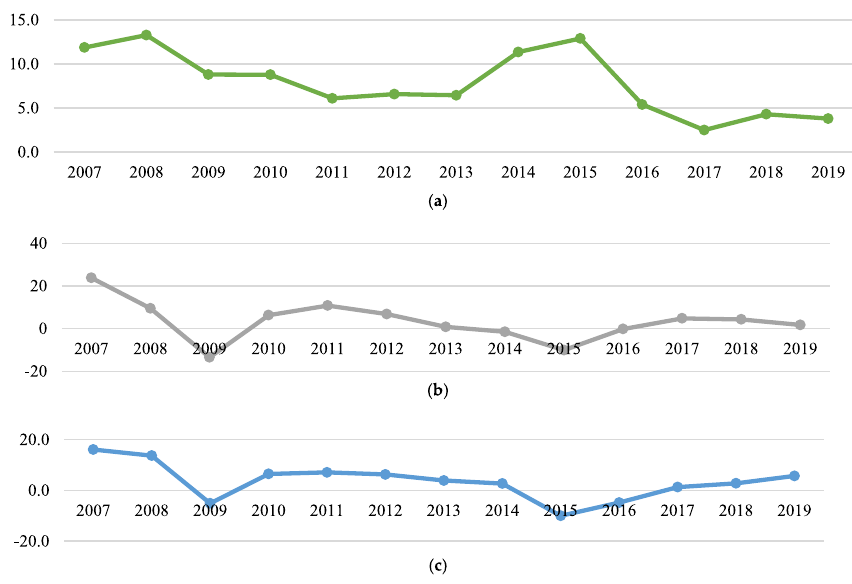
Fig. 2 a Inflation rate (CPI), %. b Growth rate of investment in fixed assets, %, c Growth rate of retail trade turnover, %. Sources : Goskomstat (2022), Bank of Russia (2020), author’s